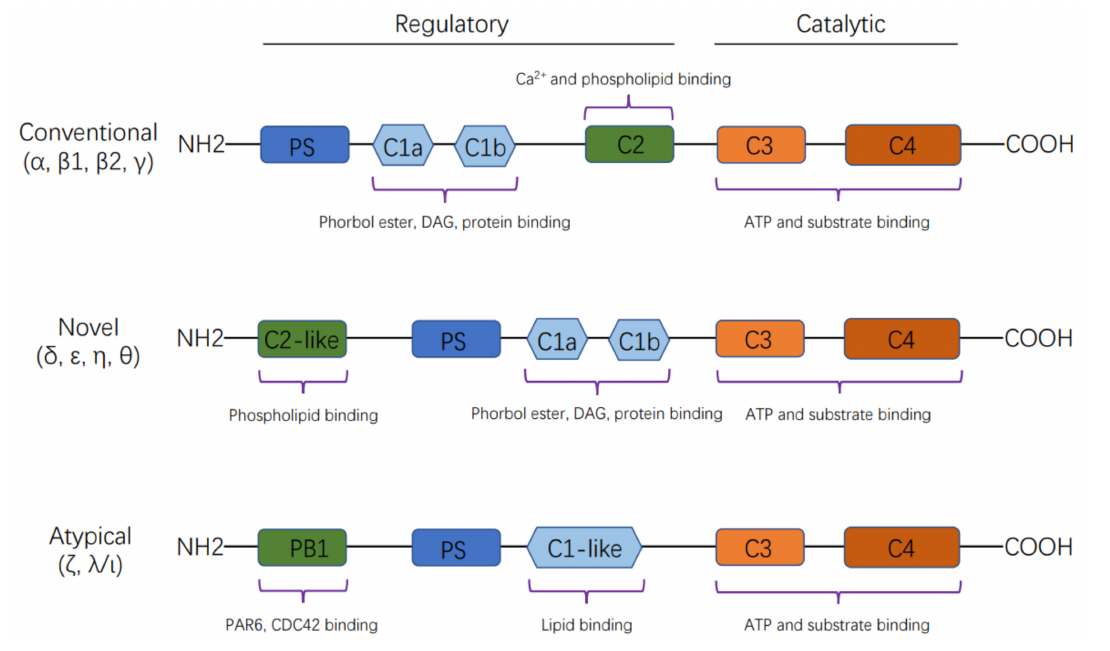
Figure 1. Schematic representation of the structure of protein kinase C (PKC) isoforms. The PKC family members are classified into three subfamilies according to their cofactor dependence: (i) con- ventional or classical PKC isozymes (cPKCs), including PKC α , PKC β 1, PKC β 2 and PKC γ , which are calcium-dependent and activated by both diacylglycerol (DAG) and phosphatidylserine (PS); (ii) novel PKC isozymes (nPKCs), including PKC δ , PKC ε , PKC η and PKC θ , which are calcium- independent and regulated by DAG and PS; and (iii) atypical PKC isozymes (aPKCs), including PKC ζ and PKC λ / ι , which are calcium-independent and do not require DAG for activation, although PS can regulate their activity.